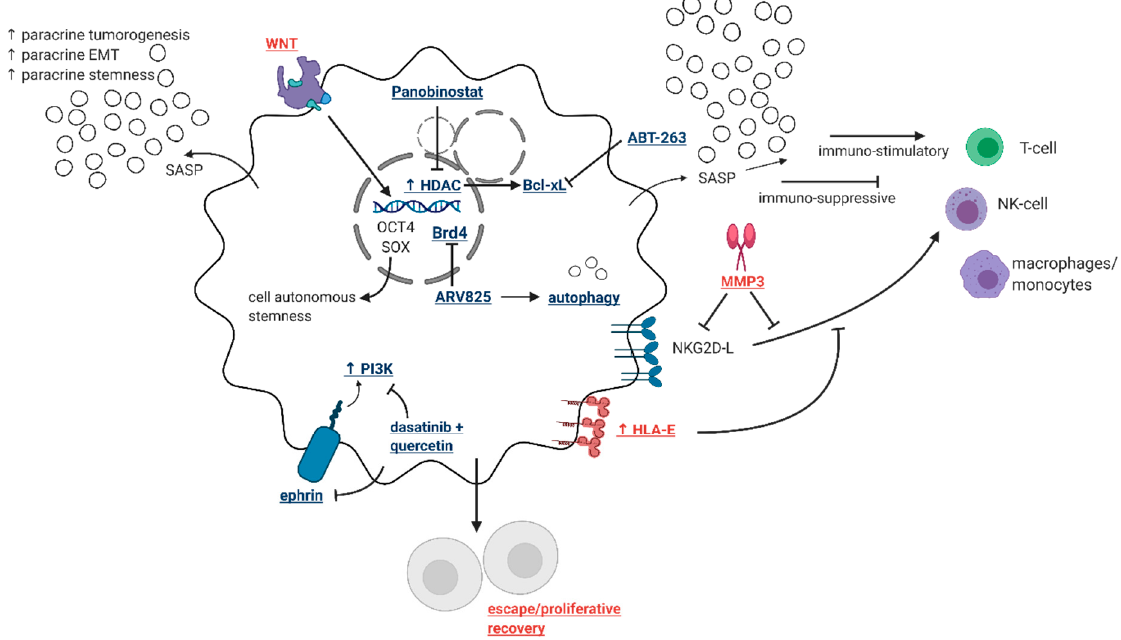
Figure 2. Validated and potential therapeutic targets to eliminate senescent cells. The accumulation of senescent cells is arguably disadvantageous to patient outcome due to the potential for proliferative recovery, the development of cell-autonomous stemness, SASP-driven stimulation of neighboring cells, and SASP-mediated immunogenicity. Despite evidence that SASP can drive immune-cell driven elimination of senescent cells, the SASP can also be strongly immunosuppressive. Further, elevated matrix-metalloprotease secretion and HLA-E expression have been demonstrated mechanisms by which senescent cells continue to evade immune cell detection. Multiple small molecule drugs have been identified and validated as senolytics (blue bolded text), but we propose that specific targeting of the more detrimental features of senescent cells (red bolded text) may prove efficacious alternatives or supplementations to the identified drug targets. This figure was generated through biorender.com.